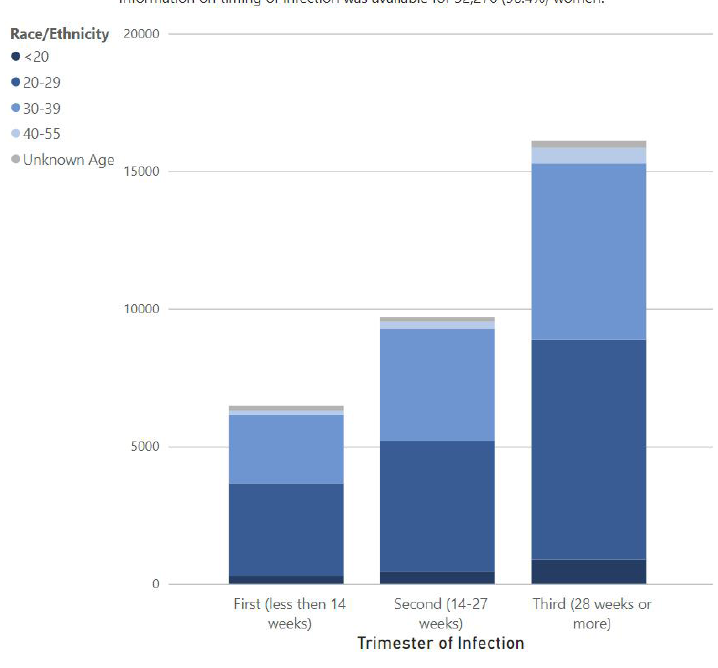
Figure 5. Data reported to CDC as of November 5, 2021